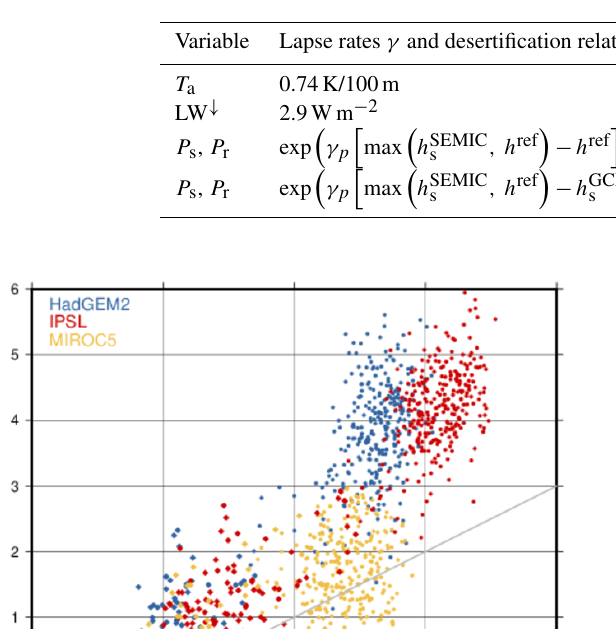
Table 1. Lapse rates and height–desertification relationship for initial corrections of the GCM output fields near-surface air temperature T a , precipitation of snow P s , precipitation of rain P r , and downwelling longwave radiation LW ↓ used as input for SEMIC. Here, h ref = 2000m is the reference height and γ p = − 0 . 6931km − 1 is the desertification coefficient.